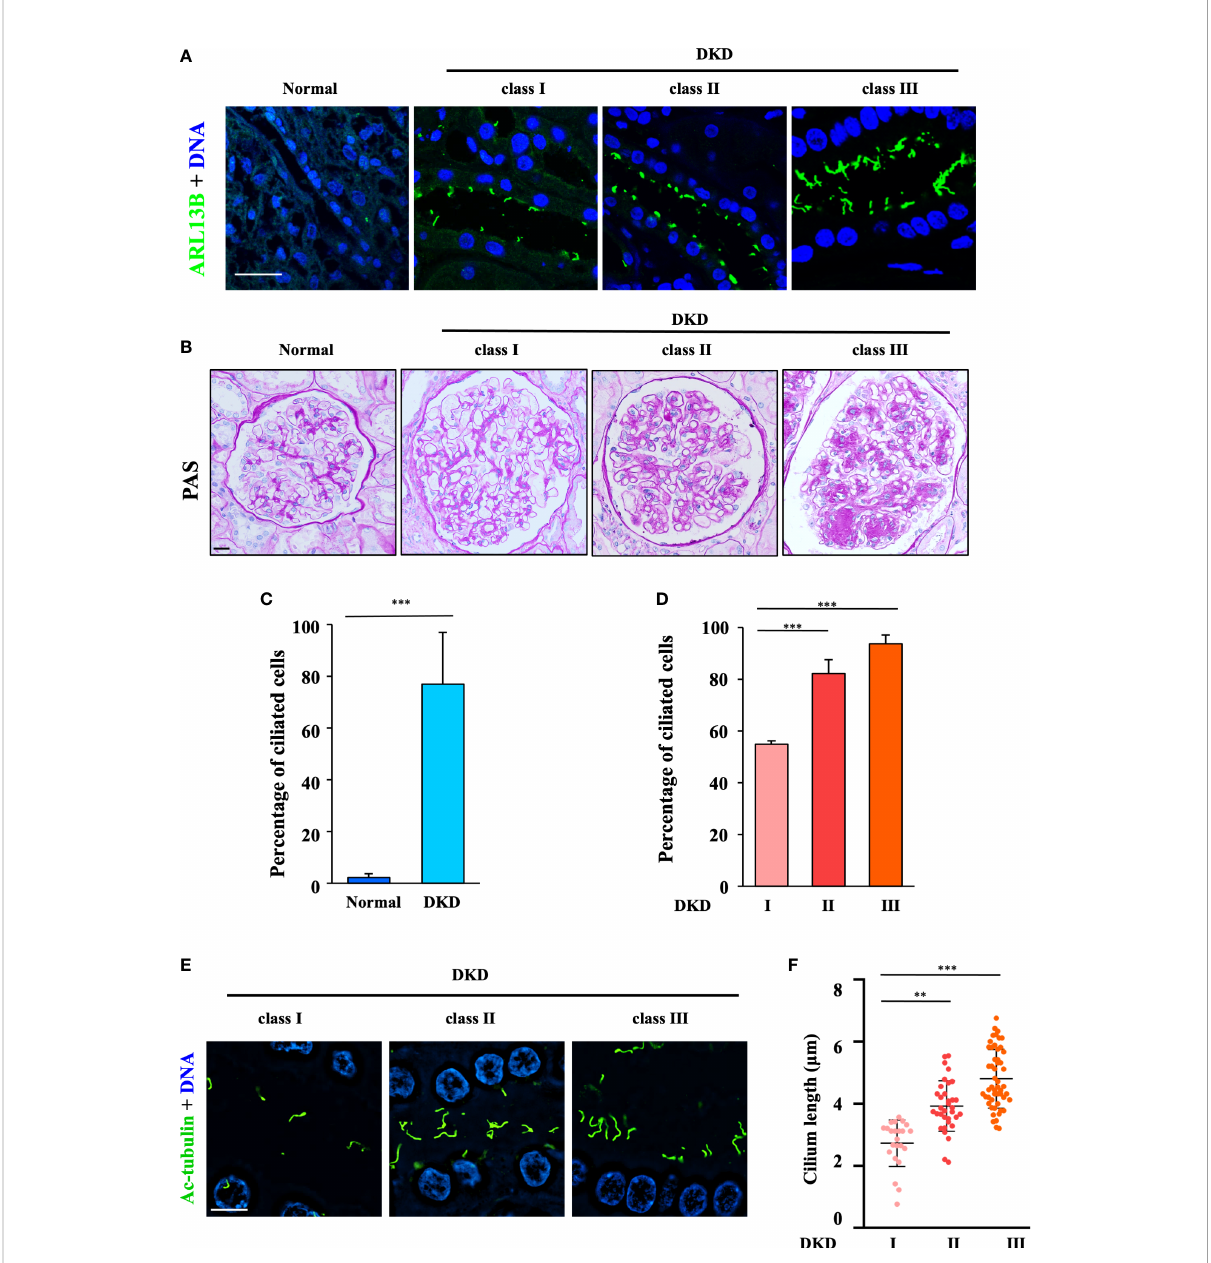
FIGURE 1 Aberrant ciliogenesis and dramatic increase in the cilium length in humans with diabetic kidney disease. (A) Human renal tissue sections were stained for the ciliary marker ARL13B (green) and DNA (blue). Scale bar, 20 m m (three subjects per group). (B) Human renal tissue sections from normal kidney poles ( n = 3); subjects with mild (Class I, n = 3), moderate (Class II, n = 3), or severe (Class III, n = 3) histopathological DKD lesions were stained with periodic acid – Schiff (PAS). Scale bar, 20 m m. (C) Quanti fi cation of the ciliated cells in all DKD subjects in (B) . The data are the means ± SD. An unpaired two-tailed t-test was performed. *** P < 0.001. (D) Quanti fi cation of ciliated cells in DKD subjects with different classes in (B) . The data are the means ± SD. One-way ANOVA was performed followed by Dunnett ’ s multiple comparisons. ** P < 0.01; *** P < 0.001. (E) Kidney sections from subjects with different classes of DKD were stained for the ciliary marker ARL13B (green) and DNA (blue) and then imaged using a superresolution microscope. Scale bar, 10 m m. (F) Quanti fi cation of the cilium length in (E) . Each dot represents one cell. The data are the means ± SD. One-way ANOVA was performed followed by Dunnett ’ s multiple comparisons. ** P < 0.01; *** P <